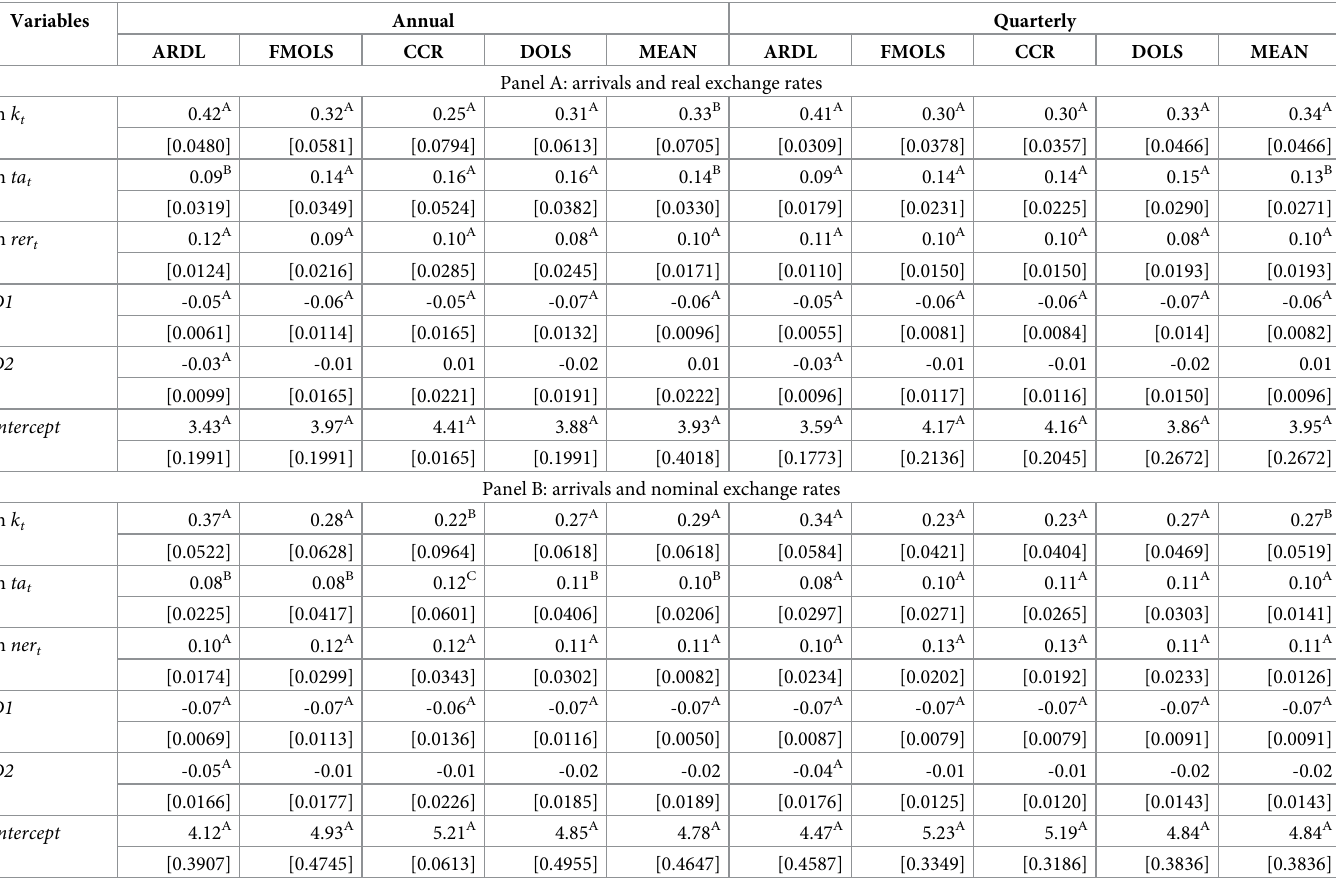
Table 7. Tourist arrivals